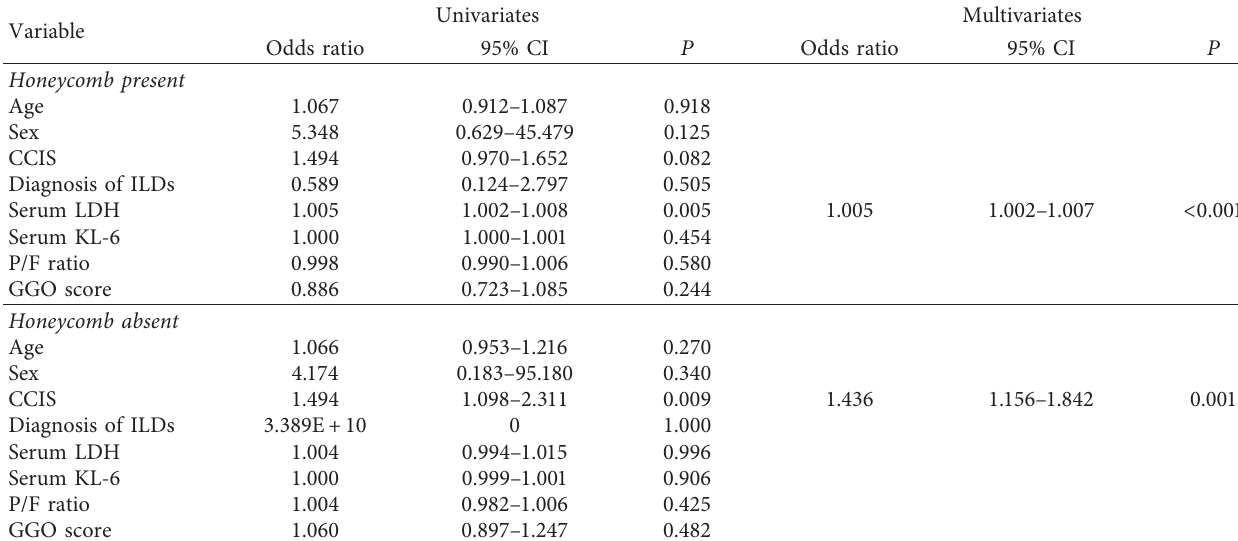
Table 4: Univariate and multivariate analysis of primary predictors of 3-month